Question: What does this figure show? Answer in one sentence.
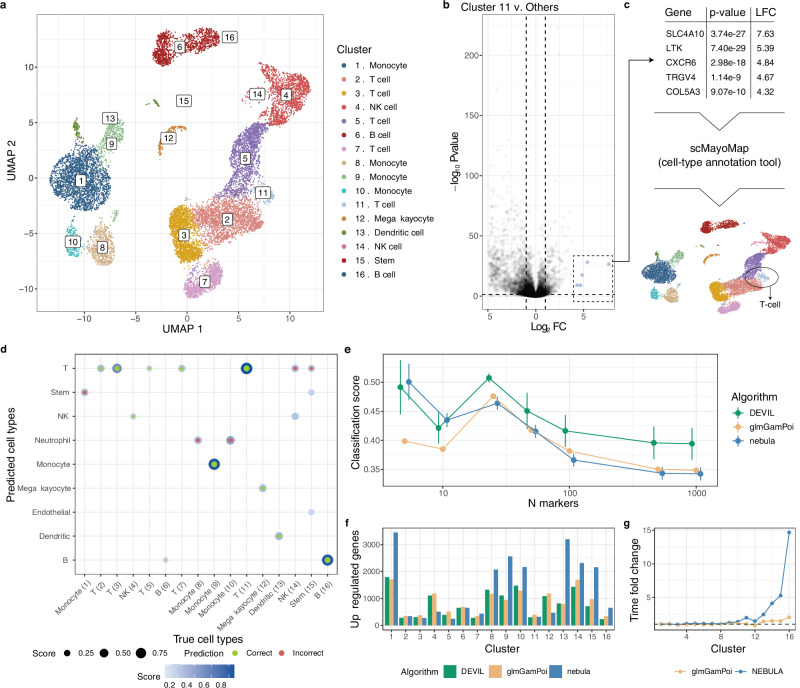
Answer: Identification of cell types from scDE markers of PBMC cells of multiple patients. a UMAP visualization of cell populations published by Hao et al. 41 . Sixteen transcriptionally distinct clusters were identified and annotated using ground truth cell type labels, including T cells, B cells, monocytes, and additional immune and stromal populations. b , c Differential expression in cluster 11. A volcano plot displays gene-level LFC and statistical significance for cluster 11 versus all other clusters. Five marker genes (highlighted in light blue) exceed both expression magnitude and significance thresholds, indicating strong cluster specificity. The identified marker genes are used for automated cell type annotation with scMayoMap, indicating that cluster 11 contains T cells, consistent with its transcriptomics profile and spatial location on the UMAP in ( a ). d , e Predicted versus true cell types for automated annotation using scMayoMap. The classification matrix ( d ) compares predicted ( y axis) and true ( x axis) cell types. Circle size and color denote classification confidence, with green indicating correct and red indicating incorrect predictions. The classification accuracy ( e ) is compared across DEVIL, glmGamPoi, and NEBULA as a function of marker set size. Points show mean accuracy, and error bars denote ±1 s.d. across n = 4 P value thresholds to reflect parameter sensitivity of the analysis. f The number of differentially expressed genes identified per cluster varies by method, highlighting differences in stringency and sensitivity of each tool tested. g Relative runtime (normalized to DEVIL) across methods, combined with precision estimates in ( e ), suggests a trade-off between speed and precision. glmGamPoi is fast but less precise than DEVIL, whereas NEBULA is precise but shows increased computational cost in larger clusters. Source data are provided as a Source Data file.